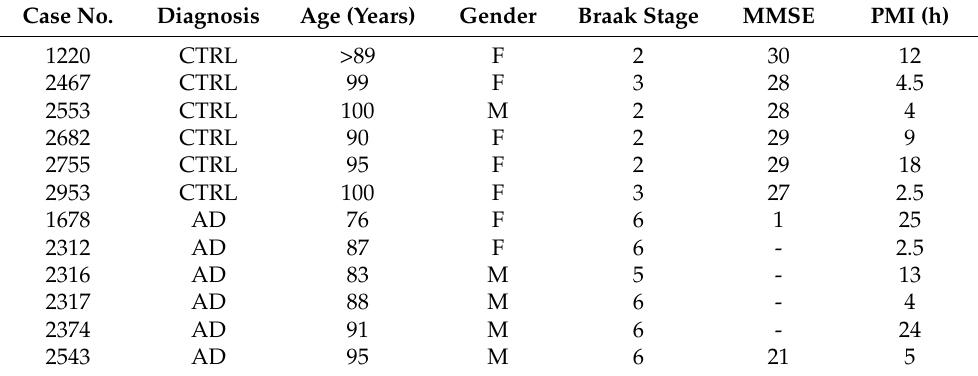
Table 1. Deidentified human clinical samples used in the study are represented with respect to the data that were made available post-mortem with their case numbers, diagnosis as non-pathological (CTRL) or pathological (AD) for the presence of plaques and tangles, age, gender, Braak staging, (Mini Mental State Examination) MMSE scores and post-mortem interval (PMI) in hours. Case